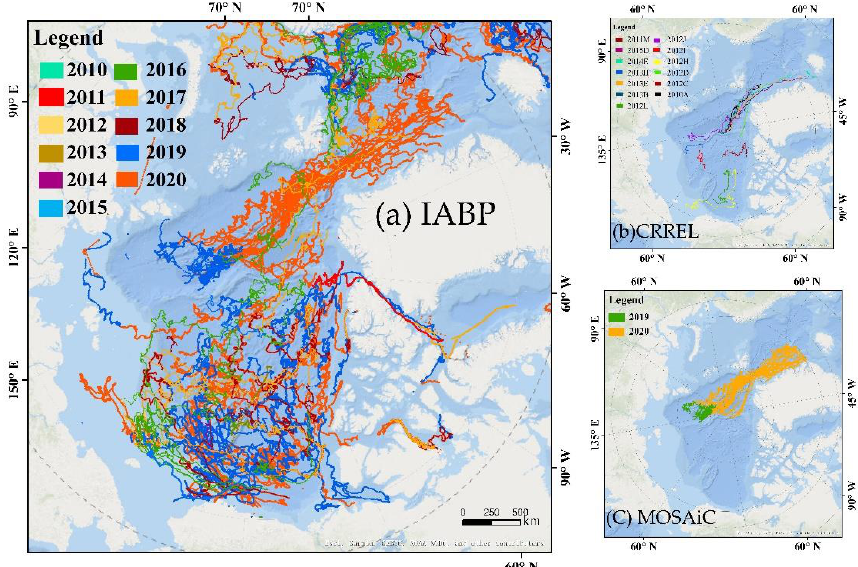
Figure 1. The trajectories of all of the buoys used in this study, and only those buoys with trajectories to the north of 70° N were utilized. ( a ) The trajectories of the IABP buoys during 2010–2020; ( b ) the trajectories of the MOSAiC buoys during 2019–2020; and ( c ) the trajectories of the CRREL buoys during 2010–2016.